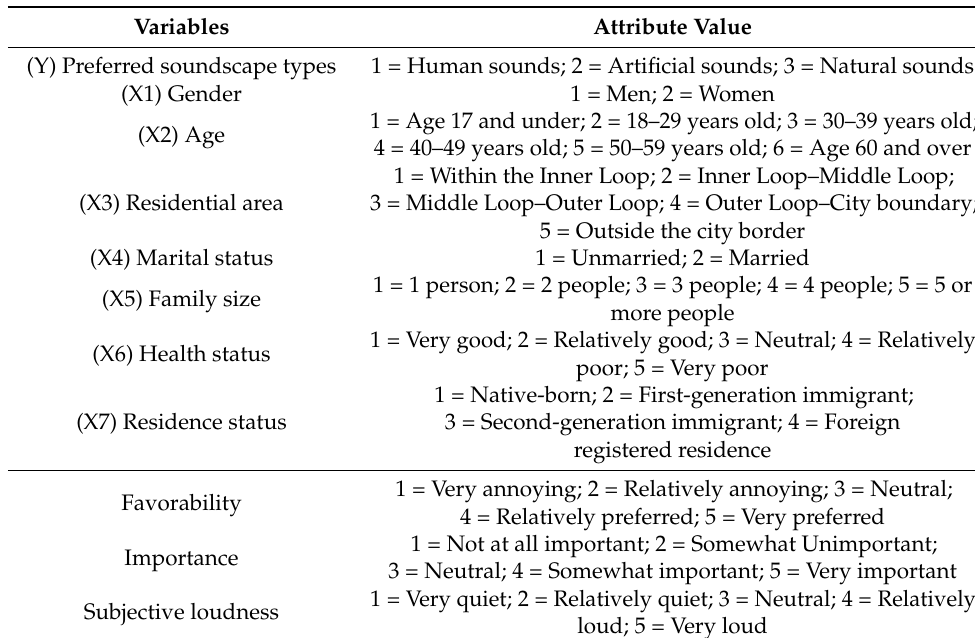
Table 2. The questionnaire variables and rating